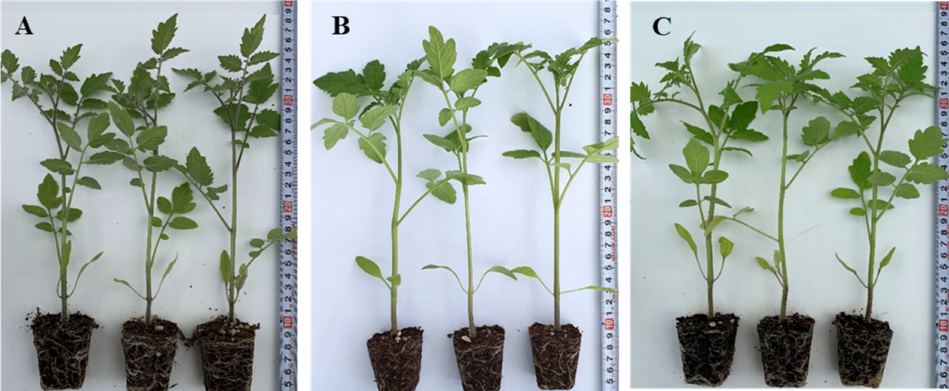
Figure 3. The morphology of tomato seedlings at 30 DAS, ( A ): interspecific hybrid (64 = JTS21-3 × SN-33),